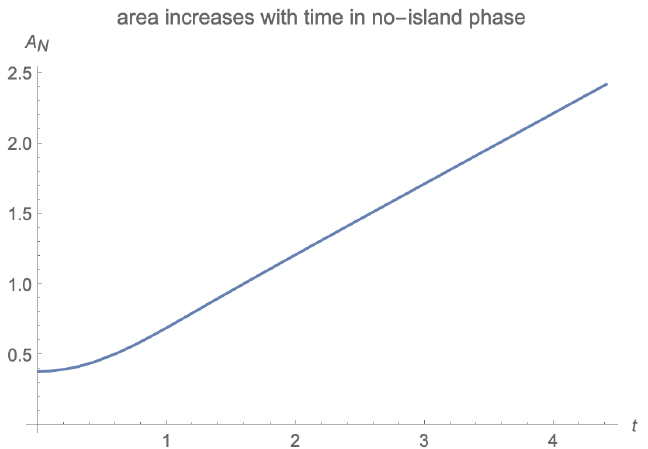
Figure 20 . The area of RT surface increases with time in the no-island phase. In this large time limit, we have lim t →∞ dA N /dt = 1 / 2 , where we have set V = 1 for